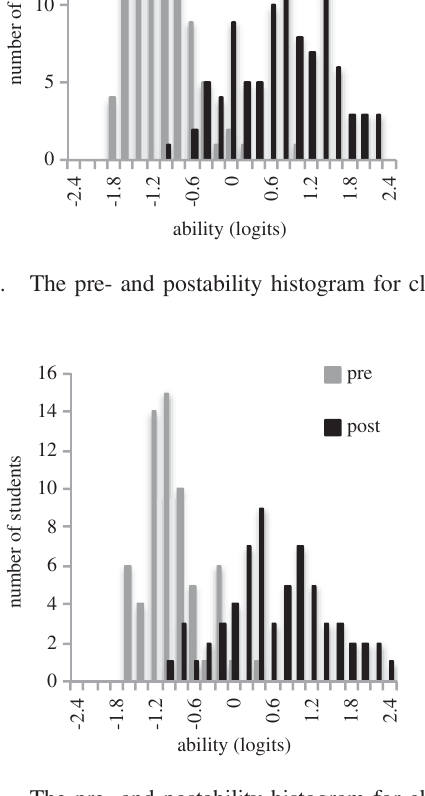
FIG. 17. The pre- and postability histogram for class 3.